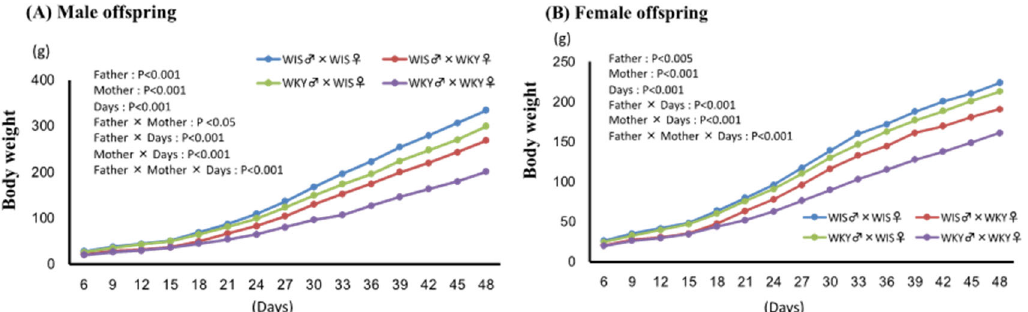
Figure 1. Effect of paternal or maternal strain on body weight of offspring. Body weight in the male ( A ) and female ( B ) pups was examined every 3 days and expressed as means ±SEM. Here, NS = not significant. Days refer to postnatal day after delivery/birth; WIS ♂ × WKY ♀ refers to pups of male Wistar (WIS) and female Wistar Kyoto (WKY) rats ( n = 6).